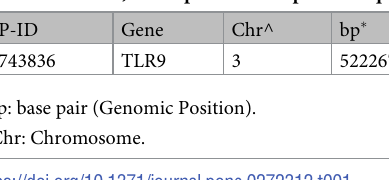
Table 1. Genotyping with the Sequenom MassARRAY 1 system (iPLEX GOLD) (Sequenom,